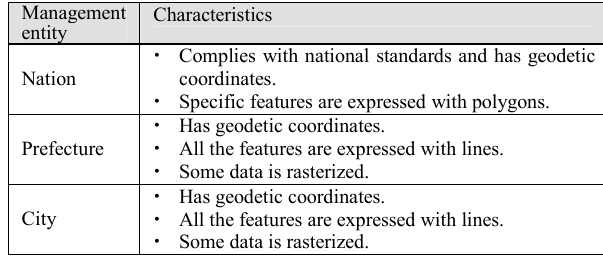
Table 2. Characteristics of as-built drawings by road